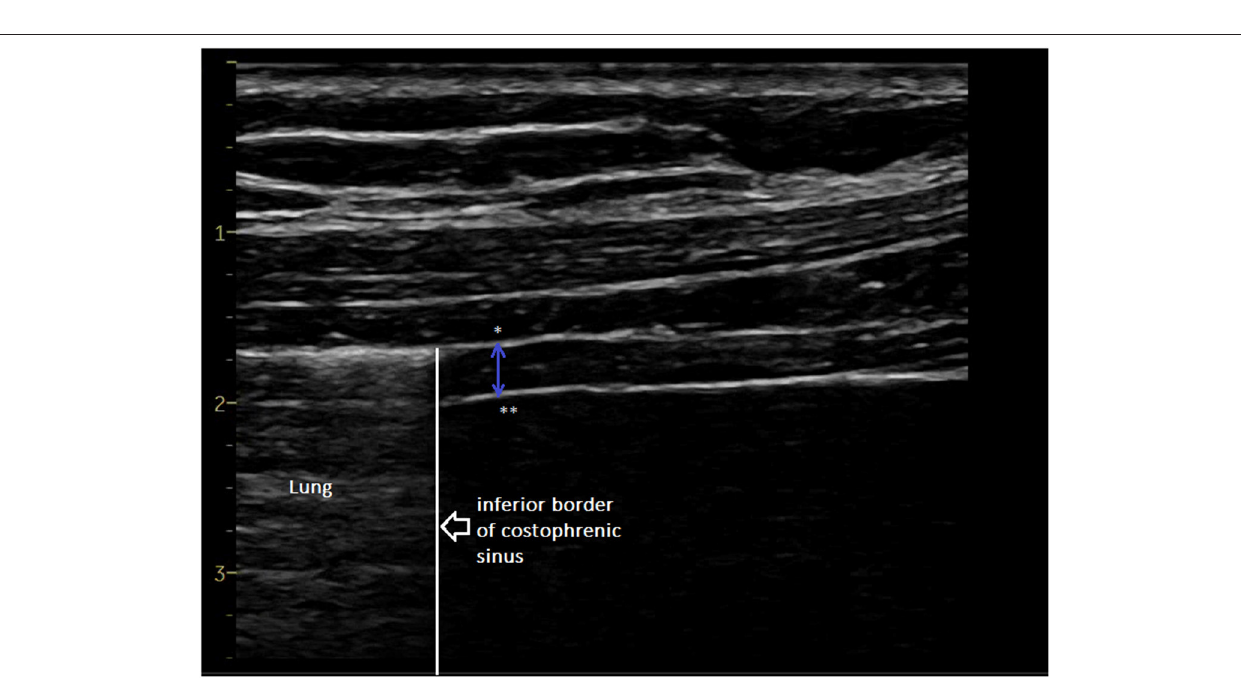
FIGURE 2 | Diaphragm thickness at end-inspiration measured from the middle of the pleural line * to the middle of the peritoneal line **. Additional file: video reporting the changes in diaphragm thickness during the breathing cycle (increase in diaphragm thickness at inspiration).